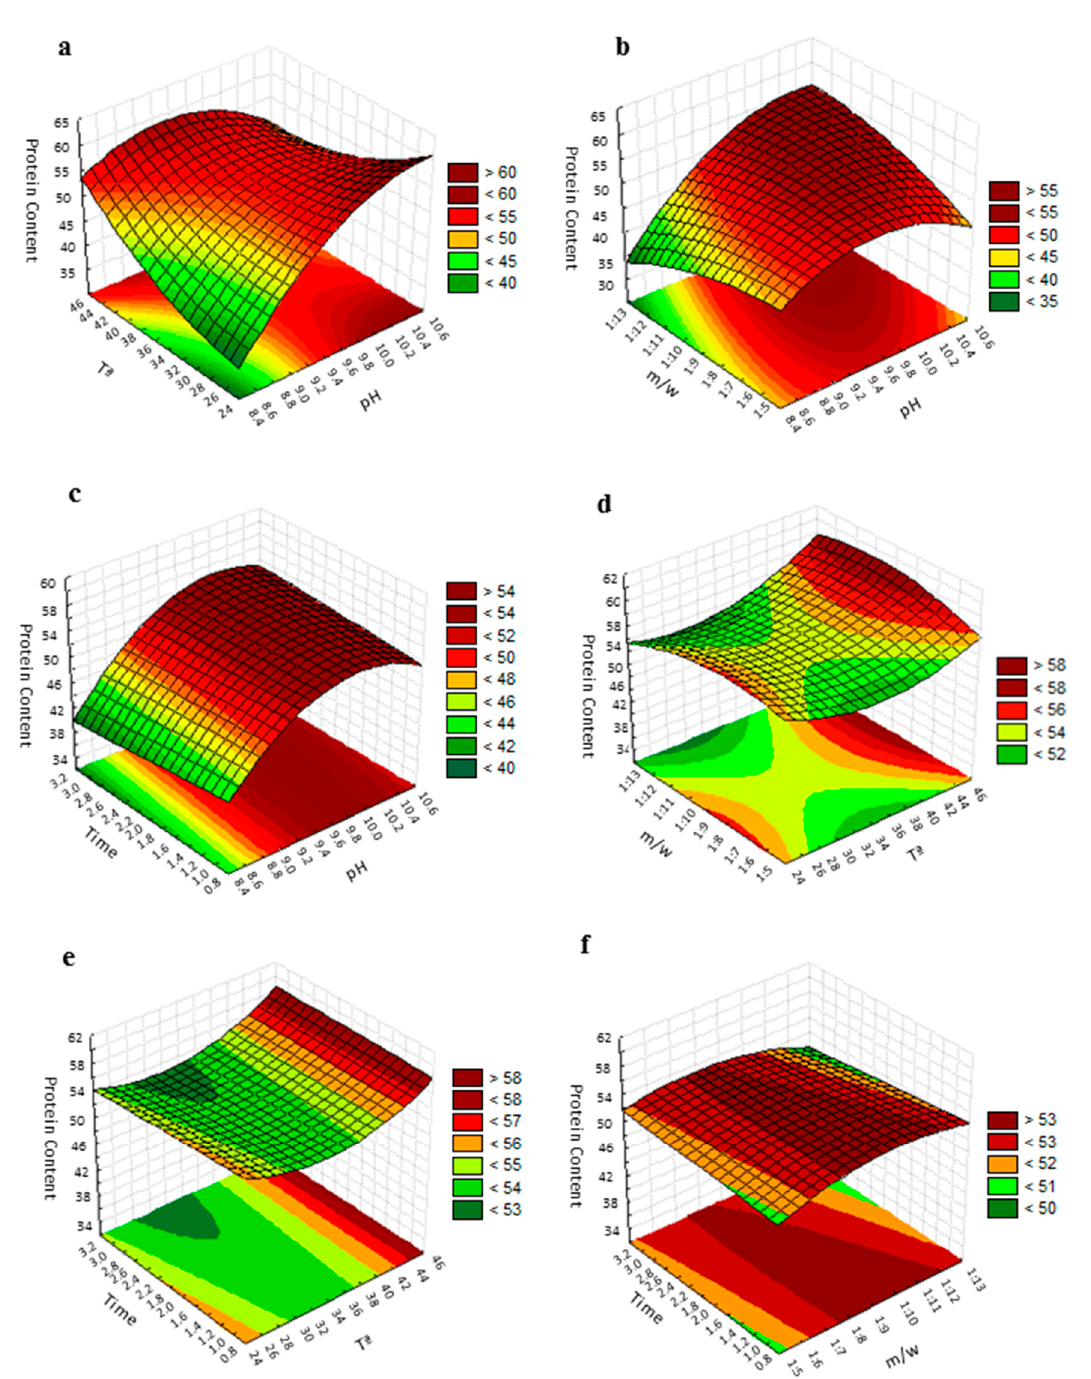
Figure 2. Response surface plot for the protein purity of the grape seed meal: ( a ) effect of pH and temperature on protein purity with the meal/water ratio of 1:9 and an extraction time of 2 h; ( b ) effect of pH and the meal/water ratio on protein purity with a temperature of 35 °C and an extraction time of 2 h; ( c ) effect of pH and extraction time on protein purity with the meal/water ratio of 1:9 and a temperature of 35 °C; ( d ) effect of temperature and the meal/water ratio on protein purity with a pH of 9.5 and an extraction time of 2 h; ( e ) effect of the temperature and extraction time on protein purity with a pH of 9.5 and a meal/water ratio of 1:9; ( f ) effect of the extraction time and the meal/water ratio on protein purity with a temperature of 35 °C and pH 9.5. Protein content is expressed as g protein/100 g CP, time in hours and T in °C.